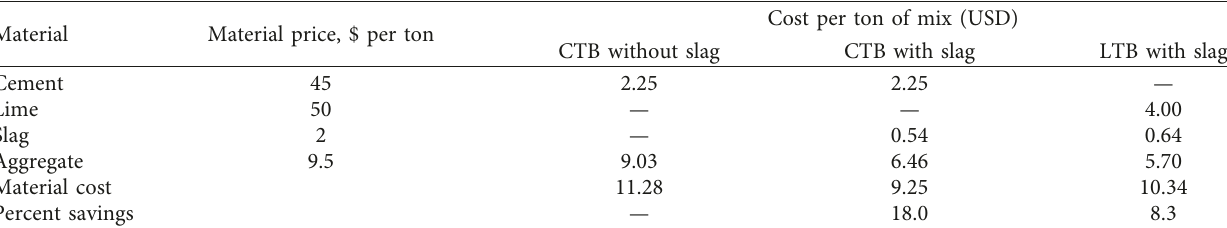
Figure 25: Emission comparison for aggregate production. (a) Cement-treated base. (b) Lime-treated Table 7: Material cost comparison.